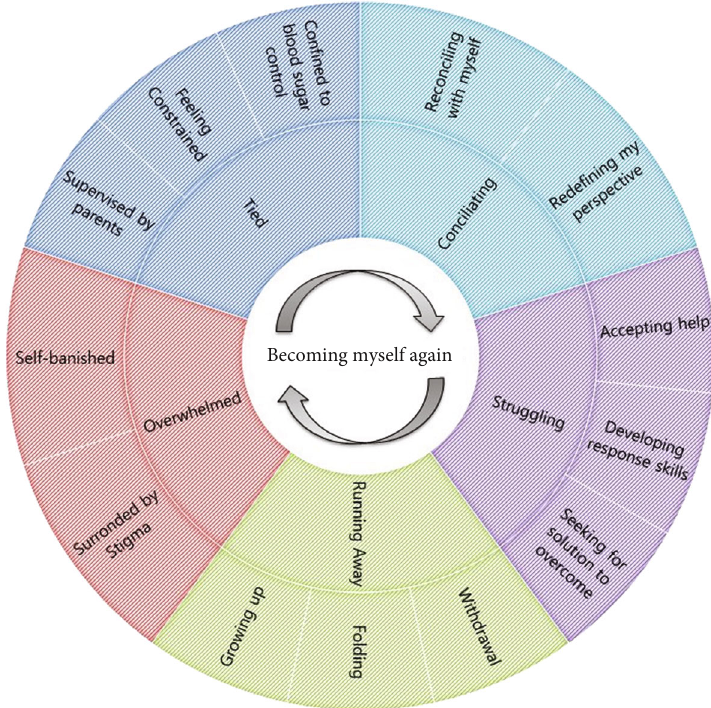
Figure 1: Process model of disease experiences of adolescents with type 1